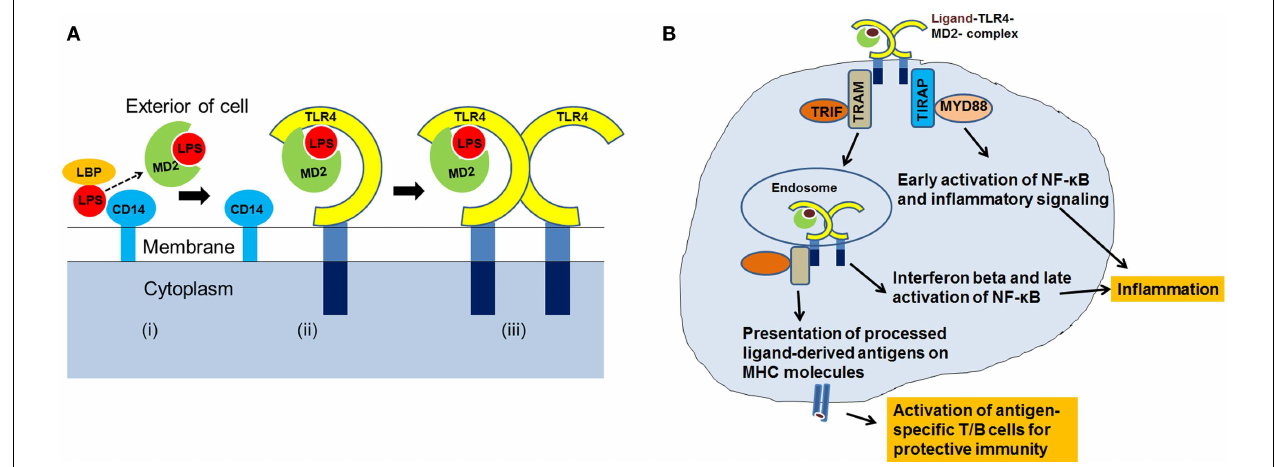
FIGURE 1 | (A) A cartoon showing assembly ofTLR4–MD2–LPS complex.The LPS is transferred to MD2 (i) Conjugation of LPS–MD2 withTLR4 (ii) then leads to dimerization ofTLR4–MD2, and formation ofTLR4–MD2–LPS complex (iii). (B) After the recognition of ligand and assembly ofTLR4-complex, co-receptors: TIRAP, MYD88,TRAM andTRIF, are recruited at the intracellular level for activation ofTLR4-signaling resulting into antigen-specific immune